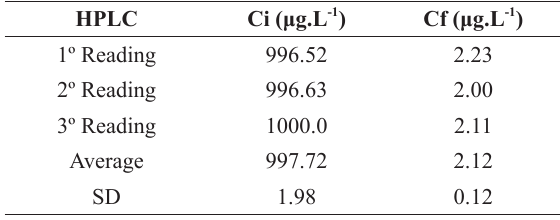
Quantitative results obtained by chromatographic analysis of individual ethinyl estradiol solution before (Ci) and after (Cf) removal by CHT.